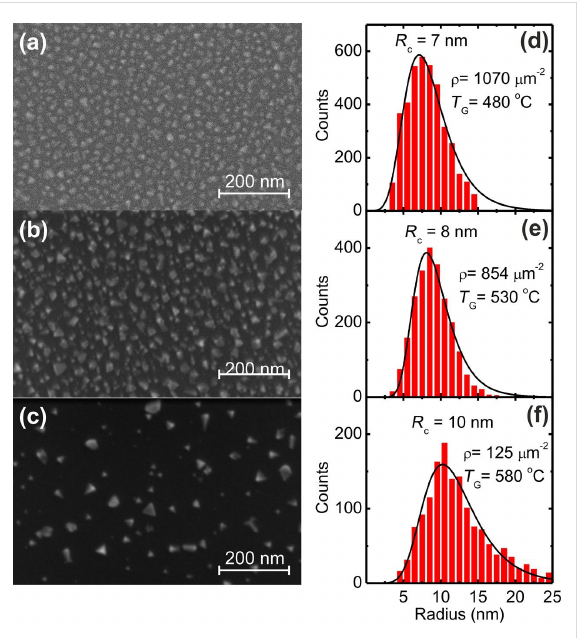
Figure 1: Representative SEM images of samples grown at (a) 490 °C, (b) 530 °C, and (c) 580 °C, showing a large surface densi- ty of triangular nanodots. Lateral size histograms of the nanodots grown at (d) 490 °C, (e) 530 °C and (f) 580 °C. R c corresponds to the most probable value of the base radius of the nanodots, while ρ is the areal density of the nanodots.